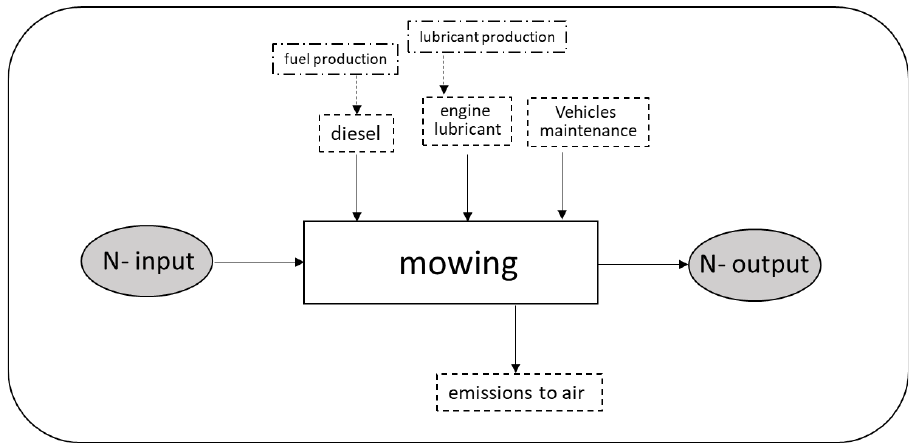
Figure 2. System boundaries used in the Life Cycle Assessment (LCA) of mowing operations in the canal network of the Burana–Volano–Navigabile (BVN) basin. The solid and dashed boxes represent foreground and background processes respectively. The dash-dot boxes represent the production of input materials; the solid arrows depict mass